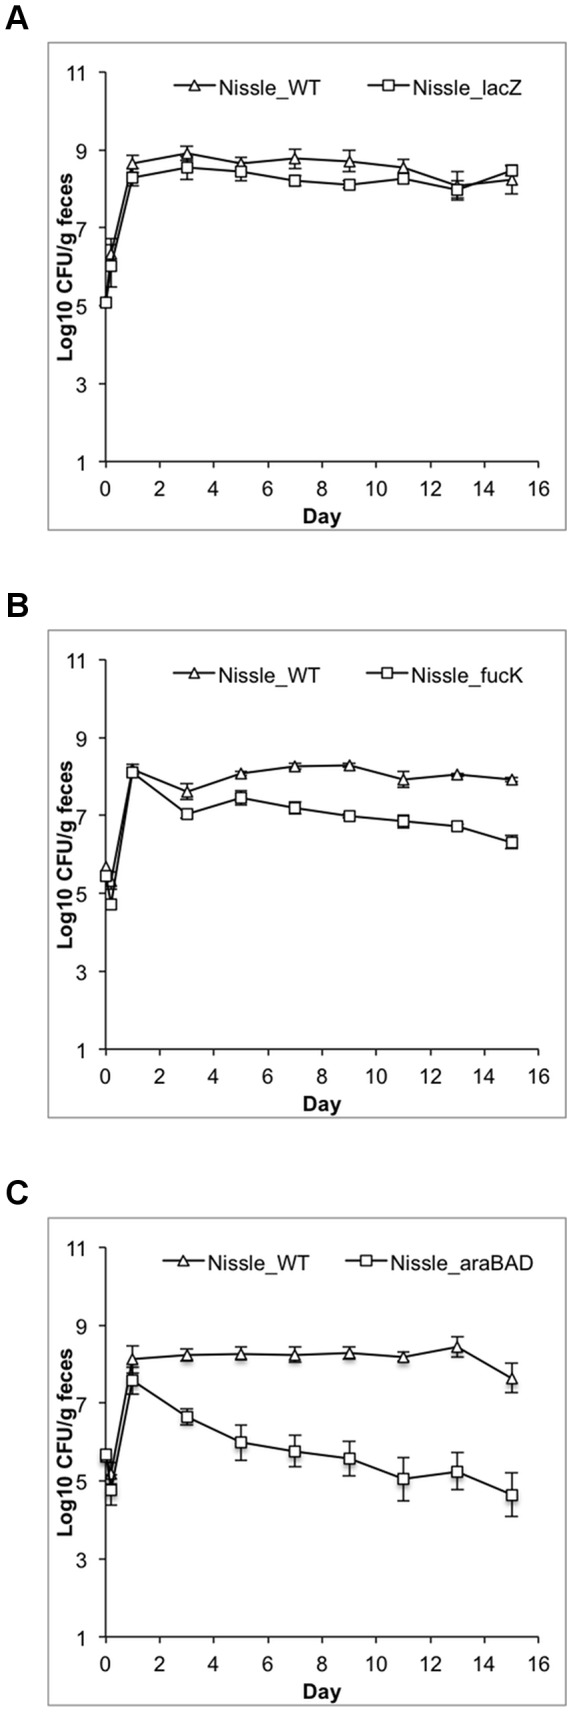
Competitive colonization of E. coli Nissle 1917 mutants vs. wild type.Data were collected as described in Figure 2. (A) ΔlacZ, which does not have a colonization defect; (B) ΔfucK, which has a moderate colonization defect; (C) ΔaraBAD, which has a severe colonization defect.